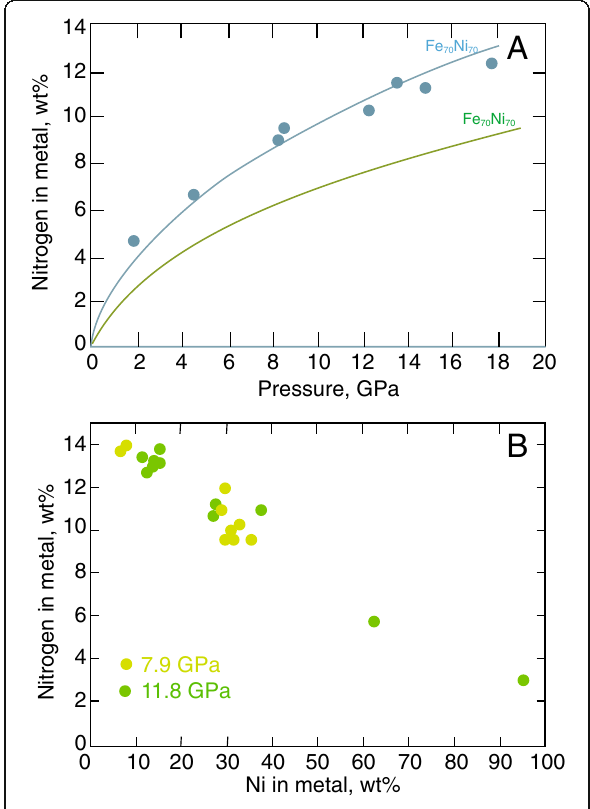
Fig. 12 Nitrogen solubility in Fe-rich (Fe,Ni) metal as a function of pressure ( a ) and Ni content ( b ) (data from Roskosz et al.